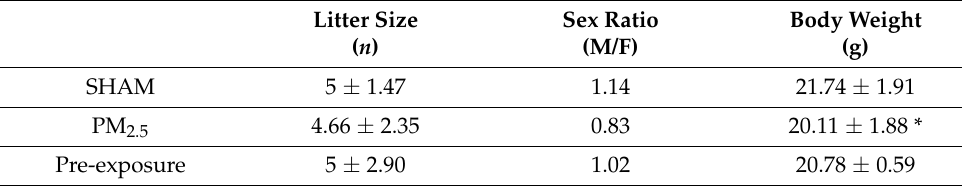
Table 2. Litter size, sex ratio and body weight of female